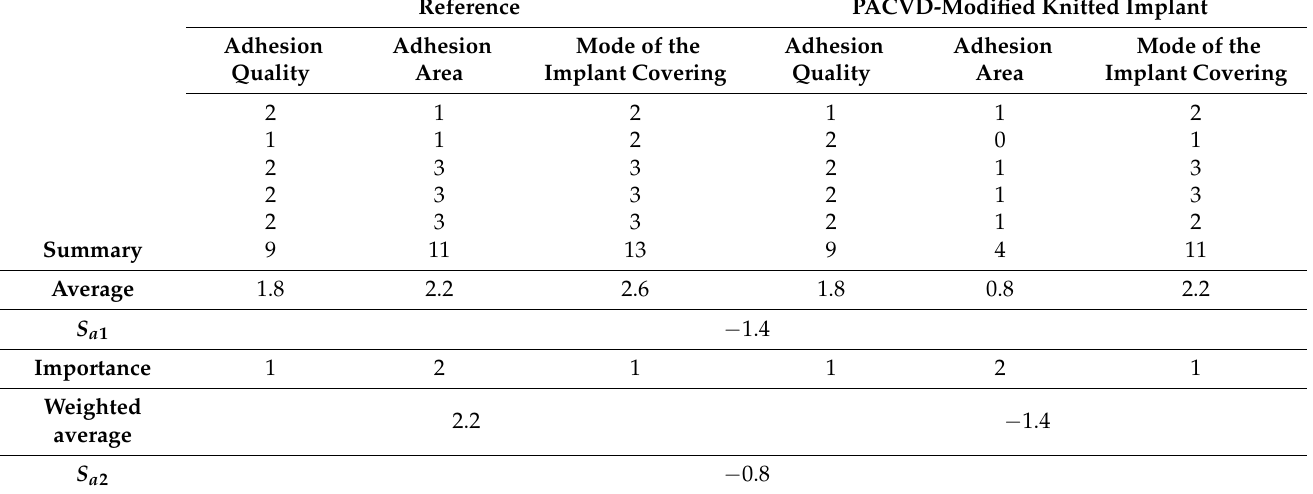
Table 6. Semi-quantitative, macroscopic evaluation of the adhesion susceptibility of the PACVD- modified implants in relation to the reference (unmodified by PACVD) sample after 4 weeks of the intra-abdominal